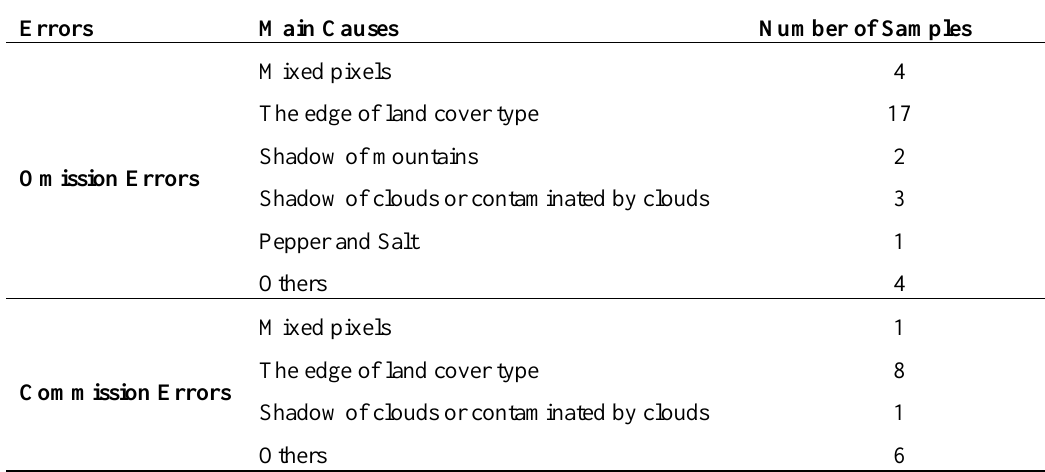
Table 3. The main causes of the errors.